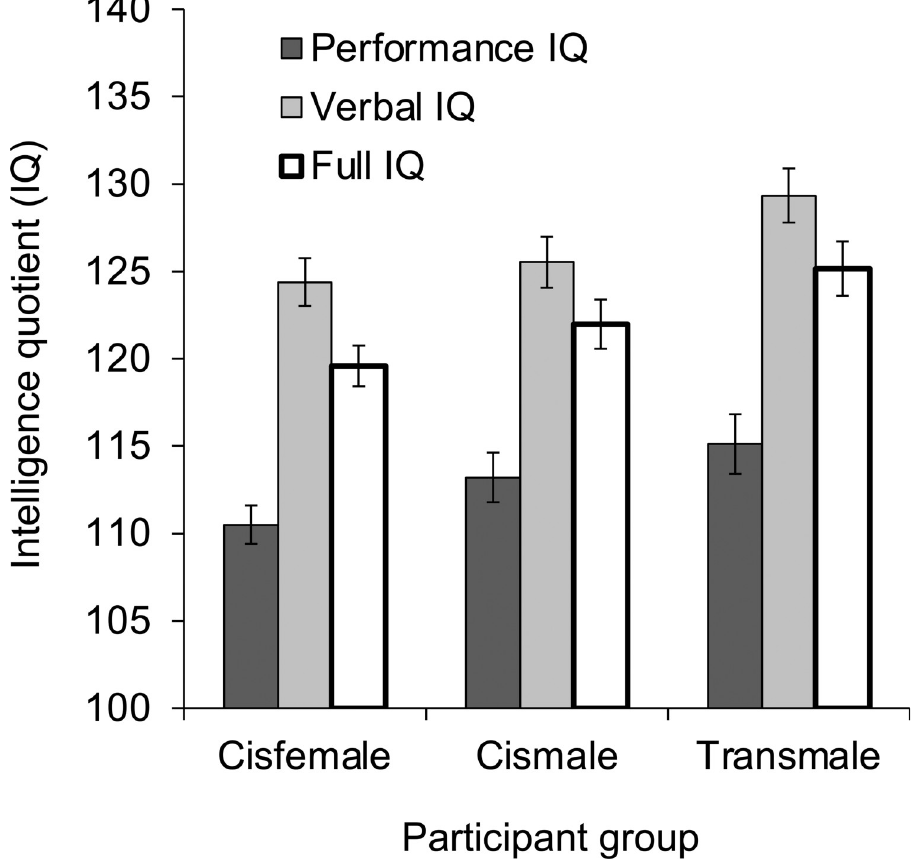
Fig 1. Intelligence quotient. Intelligence quotient (IQ) displayed as a function of participant group (cisfemale, cismale, transmale) and type of intelligence (Performance IQ, Verbal IQ, Full IQ). Error bars indicate standard error of the